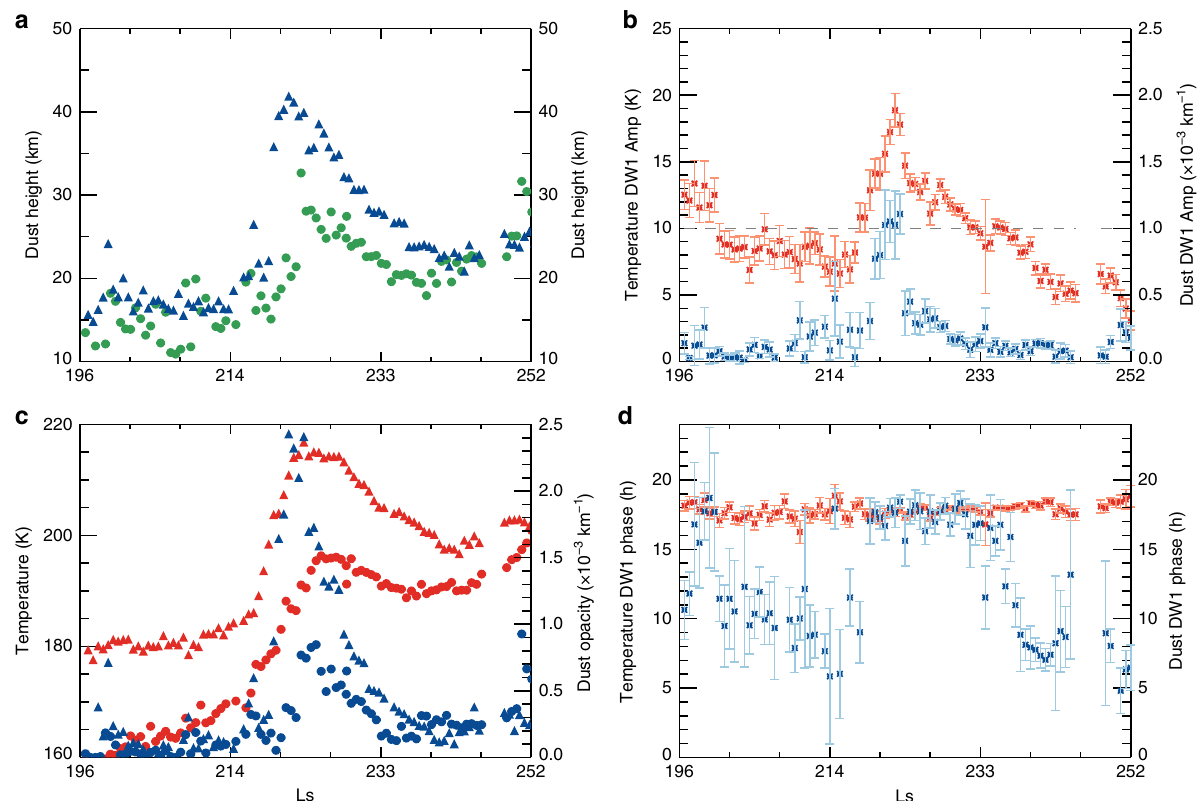
Fig. 2 Evolution of the dust diurnal variation at 62.5° S during A-season regional dust storm in Mars year 33. a Dust height corresponding to the zonal- mean dust opacity of 0.0005 (triangles for the daytime and circles for the nighttime). An example of the dust height diurnal variation with multiple local times during the peak time of dust storm is illustrated in Supplementary Fig. 5. c Temperature (red) and dust opacity (blue) at ~50 Pa (triangles for the daytime and circles for the nighttime). Amplitudes ( b ) and phases ( d ) of the temperature DW1 (red) and dust opacity DW1 (blue) at ~50 Pa, which is within the main altitude range of the dust diurnal variation. The period runs from L s = ~196° to ~252° (90 sols, 10 sols for each tick interval of x -axis). Uncertainties in ( a , c ) are less than 5%. The vertical error bars in ( b ) and ( d ) indicate the 1-sigma con fi dence